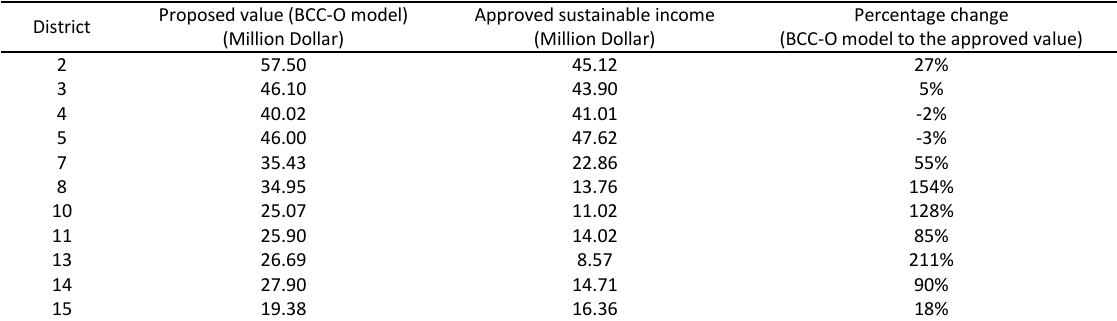
Table 2: The optimized value of sustainable income based on the BCC-O model District